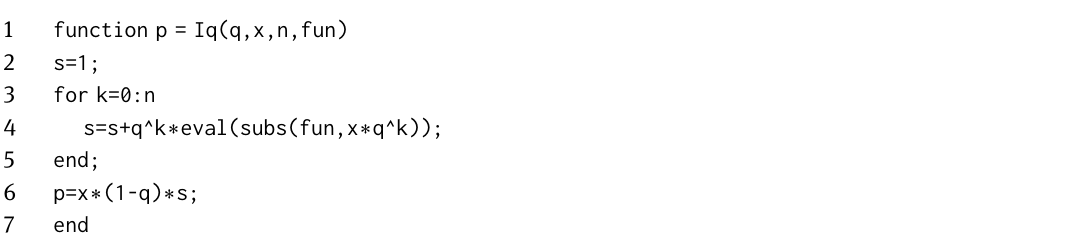
Algorithm 6. MATLAB lines for calculation of